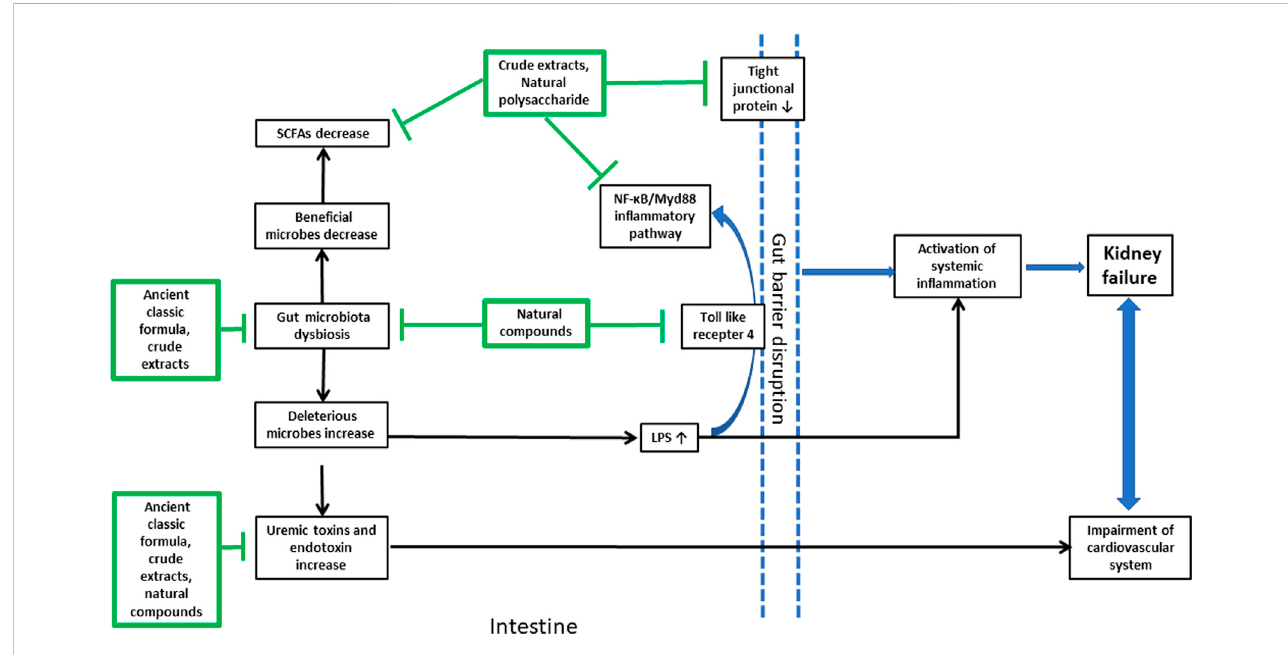
FIGURE 2 Brief summary of the natural products from plants and microorganisms used in the treatment of CKD and their multi-targets in the gut microenvironment. The arrow line with a pointed tail means promoting effects and that with a fl at tail means inhibitory